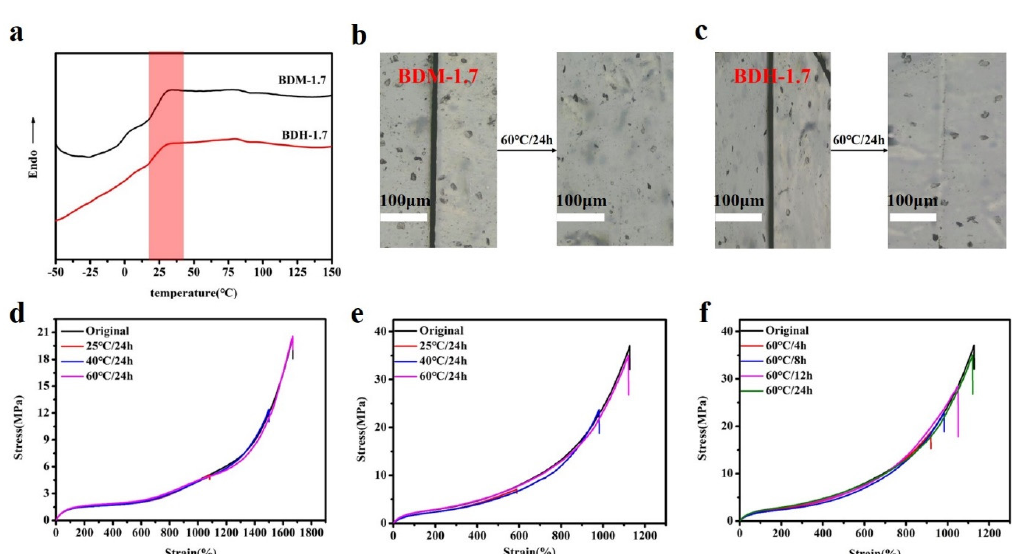
Figure 4. ( a ) DSC curves of BDM-1.7, BDH-1.7 elastomers; ( b ) and ( c ) BDM-1.7, BDH-1.7 elastomers self-healing at 60 °C for 24 h, change of scratches; ( d ) and ( e ) Stress-strain curves of BDM-1.7, BDH-1.7 elastomers self-healing at 25, 40, and 60 °C for 24 h; ( f ) Stress-strain curves for BDH-1.7 elastomers self-healing at 60 °C for 4, 8, 12, and 24 h.